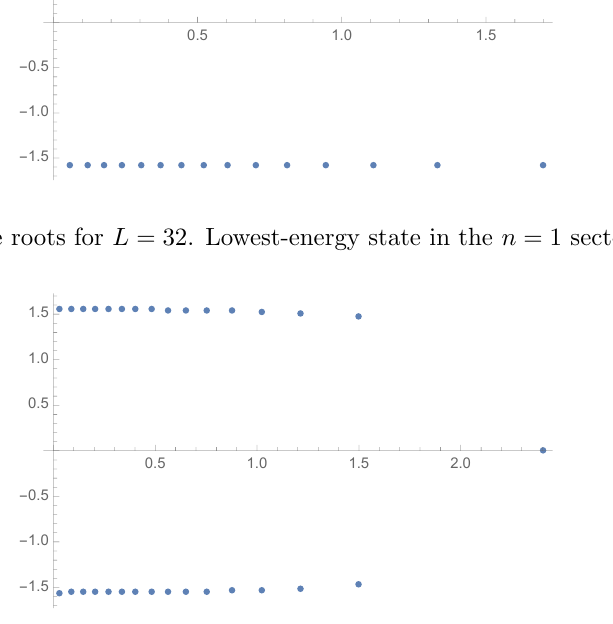
Figure 13 . Bethe roots for L = 32. First excited state in the n = 1 sector with (cid:13) = (cid:25)